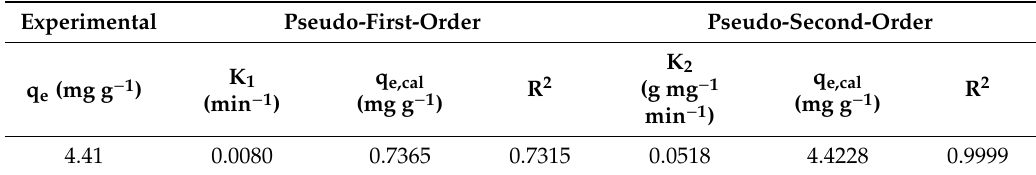
Figure 4. Kinetics models ( a ) the pseudo-first-order model and ( b ) pseudo-second-order model for methylene blue (MB) adsorption onto sugarcane bagasse 30 mesh (SCB30). Table 1. Adsorption kinetics models parameters. K 1 = rate constant of adsorption of first-order adsorption: K 2 = kinetic rate constant of pseudo-second-order adsorption process; q e = amount of MB adsorbed at equilibrium. R 2 = Correlation coefficient.